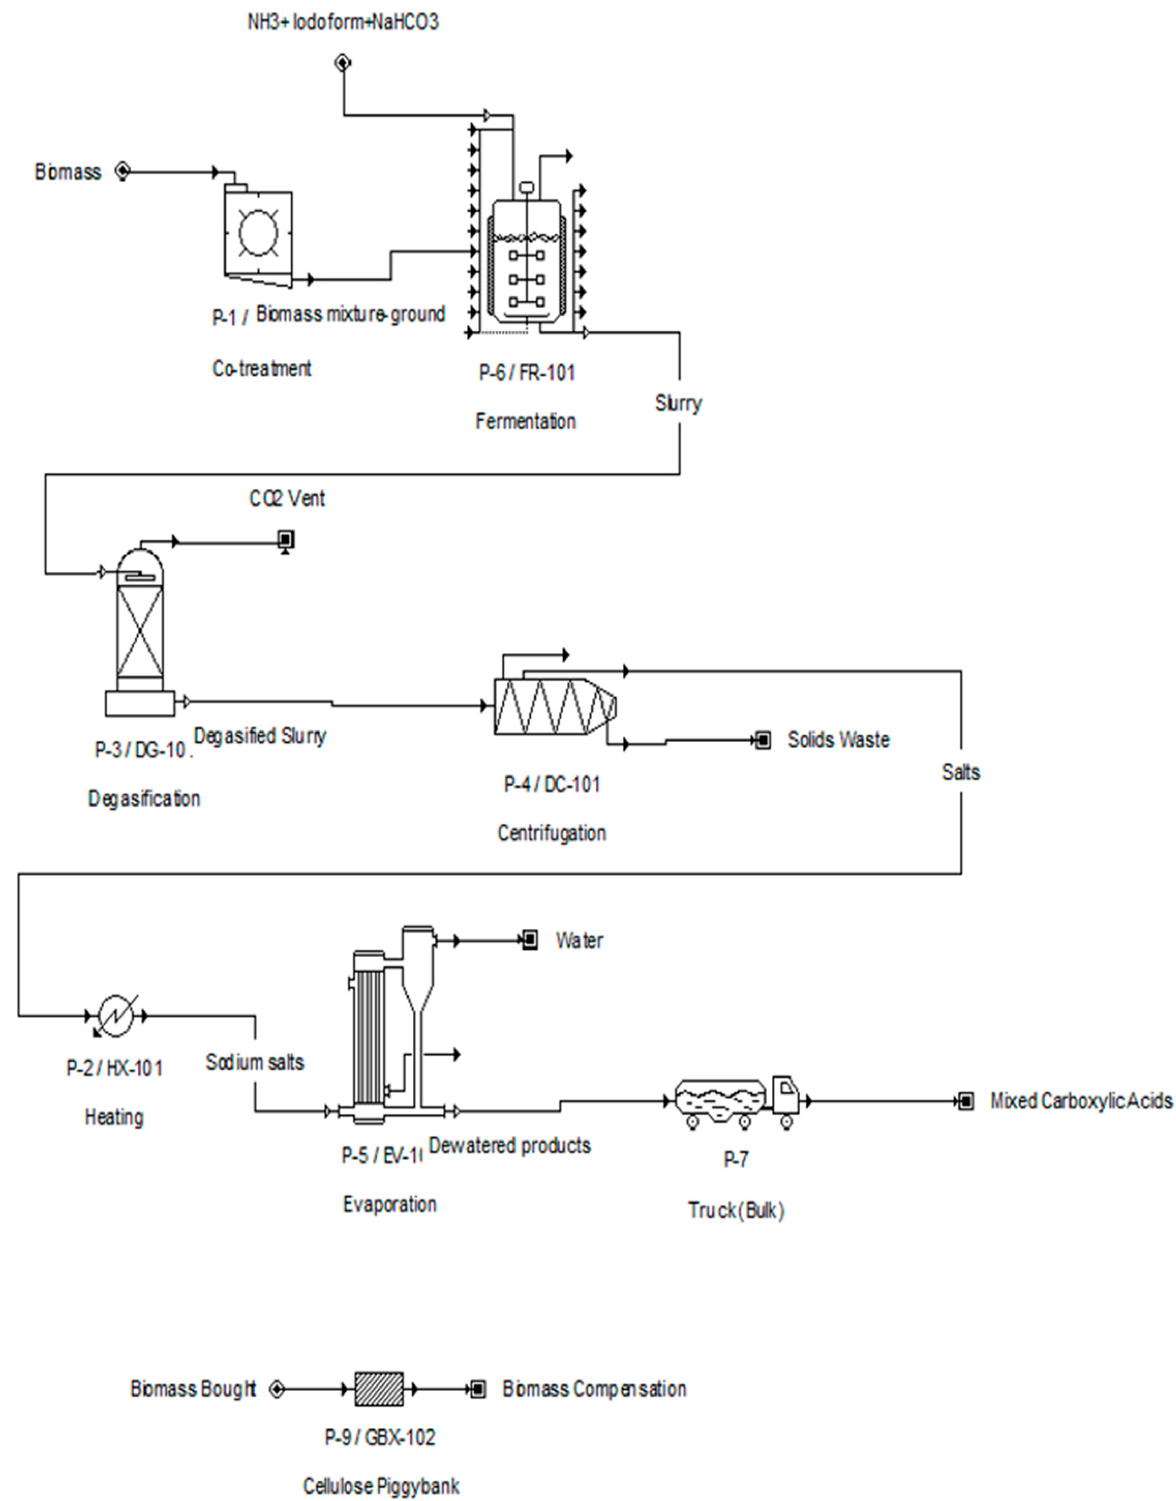
Figure 2. Schematic I/O diagram for the current MixAlco design.